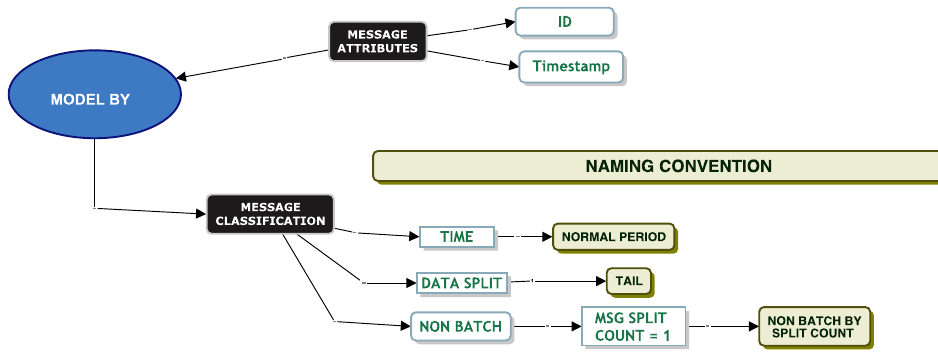
Figure 17. Non-batch by split count classification.